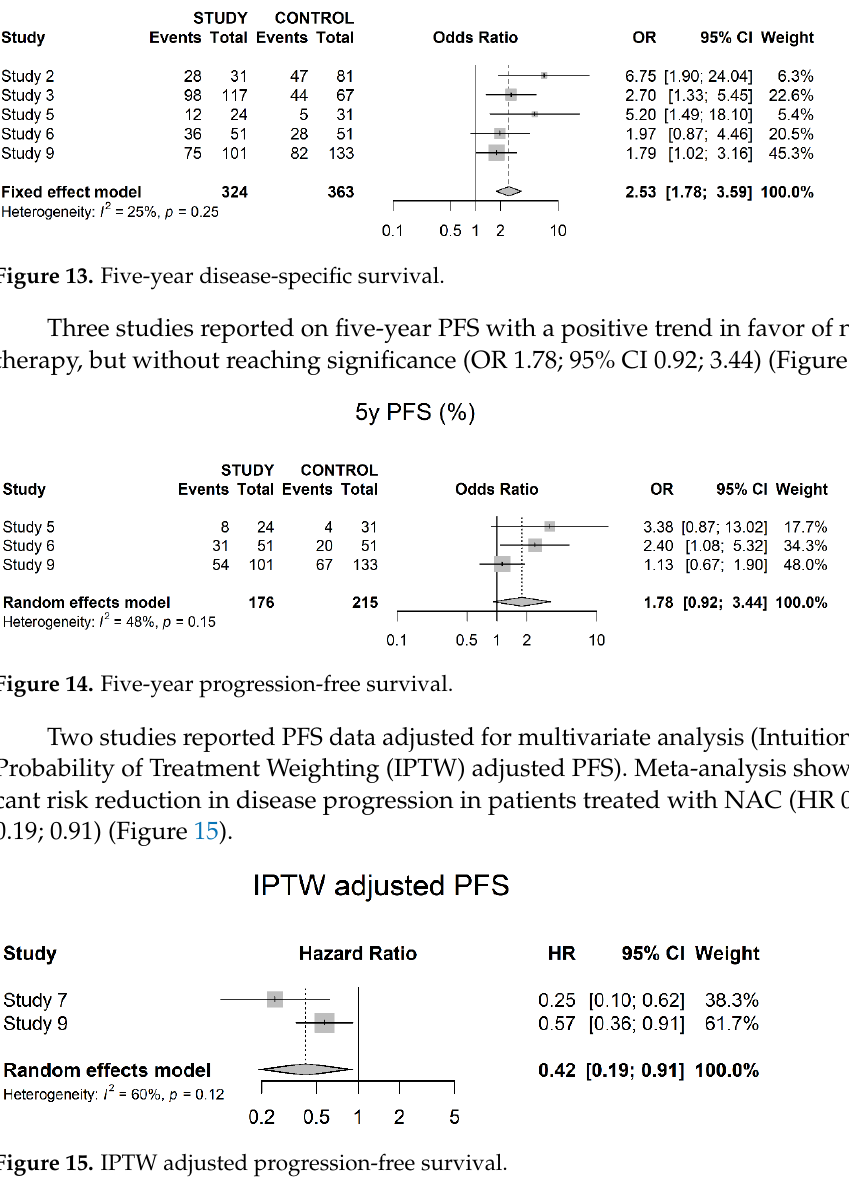
Figure 12. Five-year overall survival.